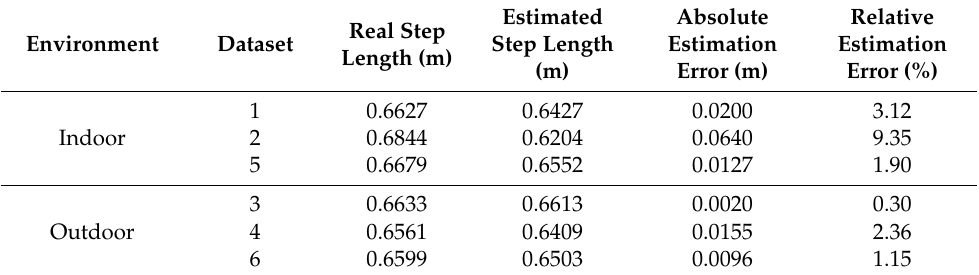
Table 2. Comparison of the real step length, estimated step length, and absolute and relative estimation error for both indoor and outdoor walking